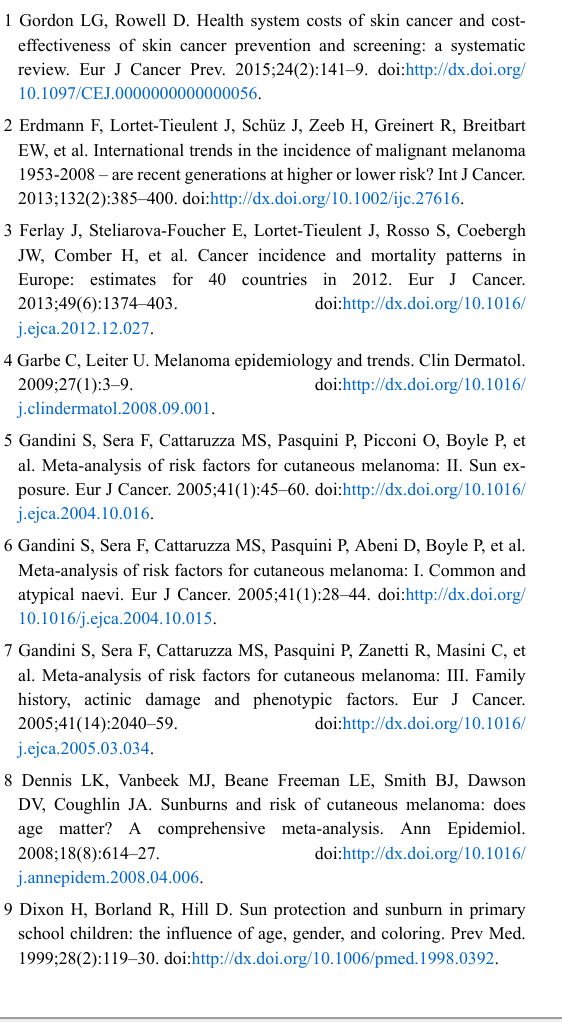
Table 5: Multivariate logistic regression analysis for sporadic use of sunscreen.